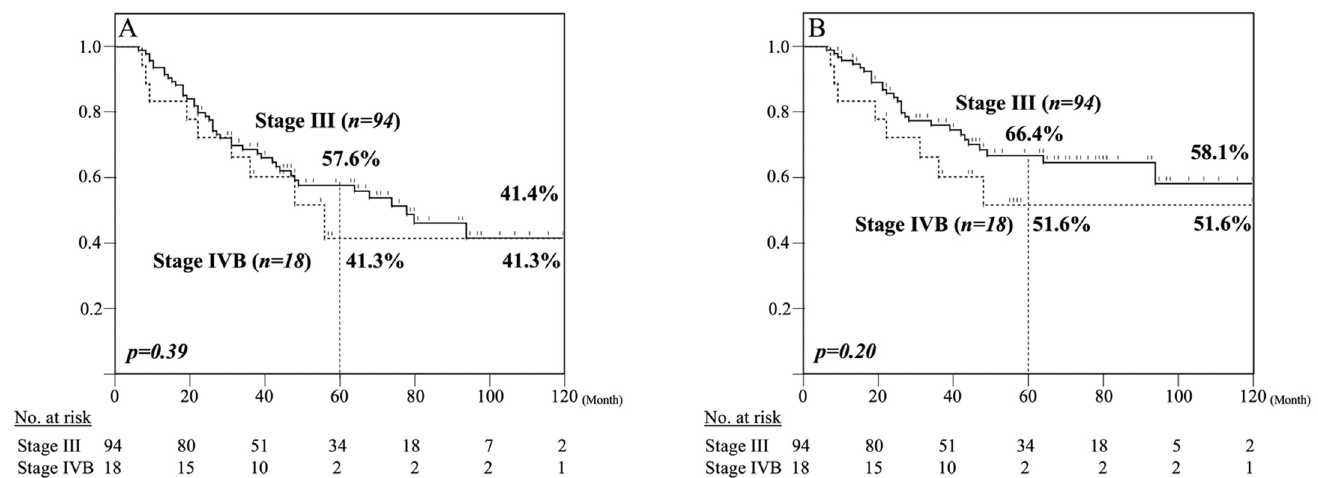
Figure 2. Kaplan–Meier analysis of clinical Stage III and IVB patients. The five-year OS was 57.6% among clinical Stage III patients and 41.3% among Stage IVB patients ( A ). The five-year DSS was 66.4% among clinical Stage III patients and 51.6% among Stage IVB patient. ( B )